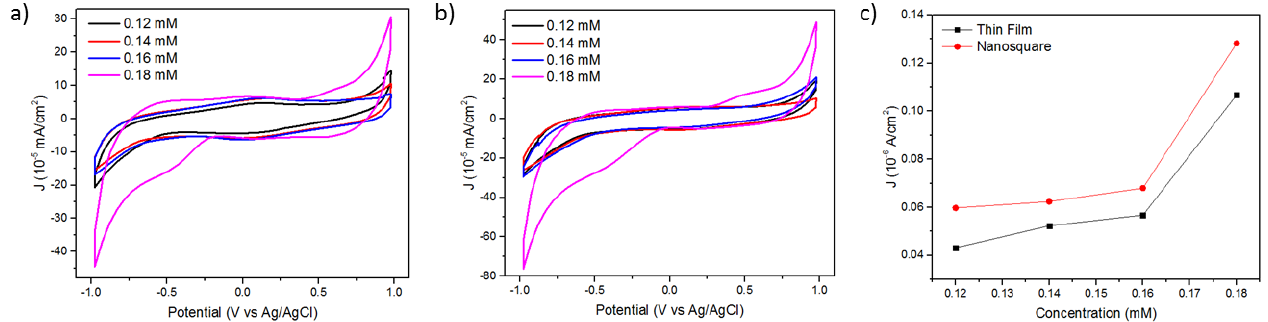
Figure 2. ( a ) CV curve of the ZnO/Au thin film in the [Fe(CN) 6 ] 3-/4- solution and ( b ) CV curve of the ZnO/Au nanosquare array in the [Fe(CN) 6 ] 3-/4- solution at various glucose concentrations from 0.12, 0.14, 0.16, 0.18 mM; and ( c ) the graph that depicts the linearity between peak currents of reduction and oxidation and the concentration with deviation standard of 0.005μA/cm 2 . The data was taken from the peak of the CV result on potential of 0.2 V vs. Ag/AgCl from the inner part of the curve up to the outer part.